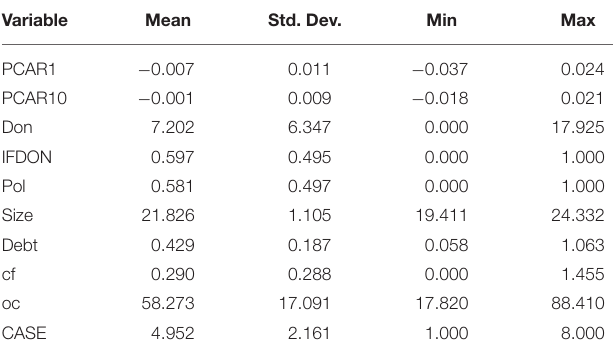
TABLE 4 | Descriptive statistics of variables of sample